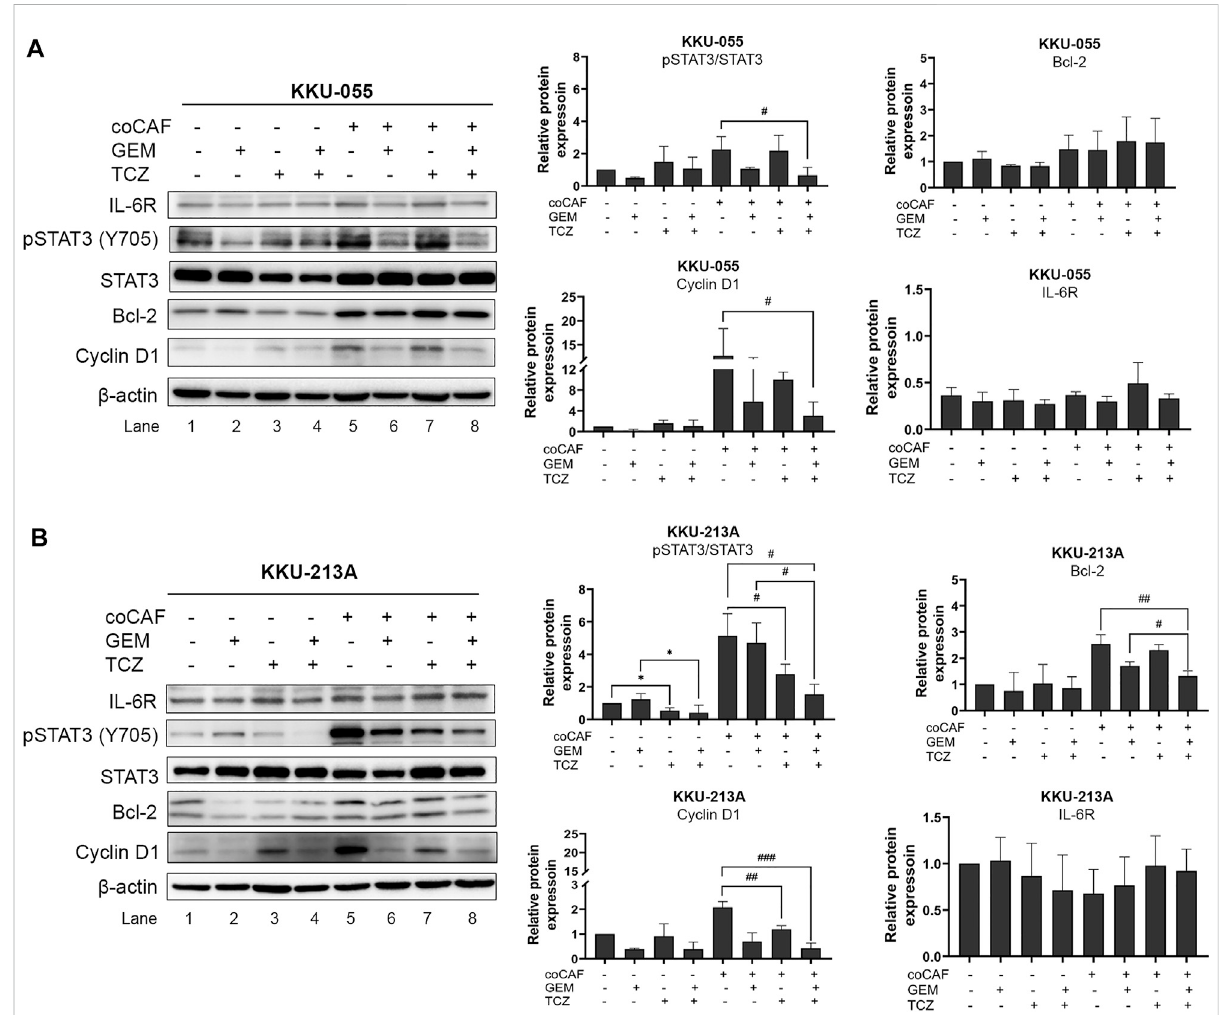
FIGURE 6 Effect of IL-6R inhibitor (TCZ) on molecular changes of CCA cells. The molecular mechanisms of (A) KKU-055 and (B) KKU-213A after co- culture with and without CAFs and then, incubation with and without gemcitabine and TCZ were assessed by western blotting. Error bars represent the standard deviation (SD) of triplicate experiments. A signi fi cant difference was determined using ANOVA and unpairedt-test (* p < 0.05 compared to those monocultured groups, # p < 0.05, ## p < 0.01, ### p < 0.001 compared to co-cultured